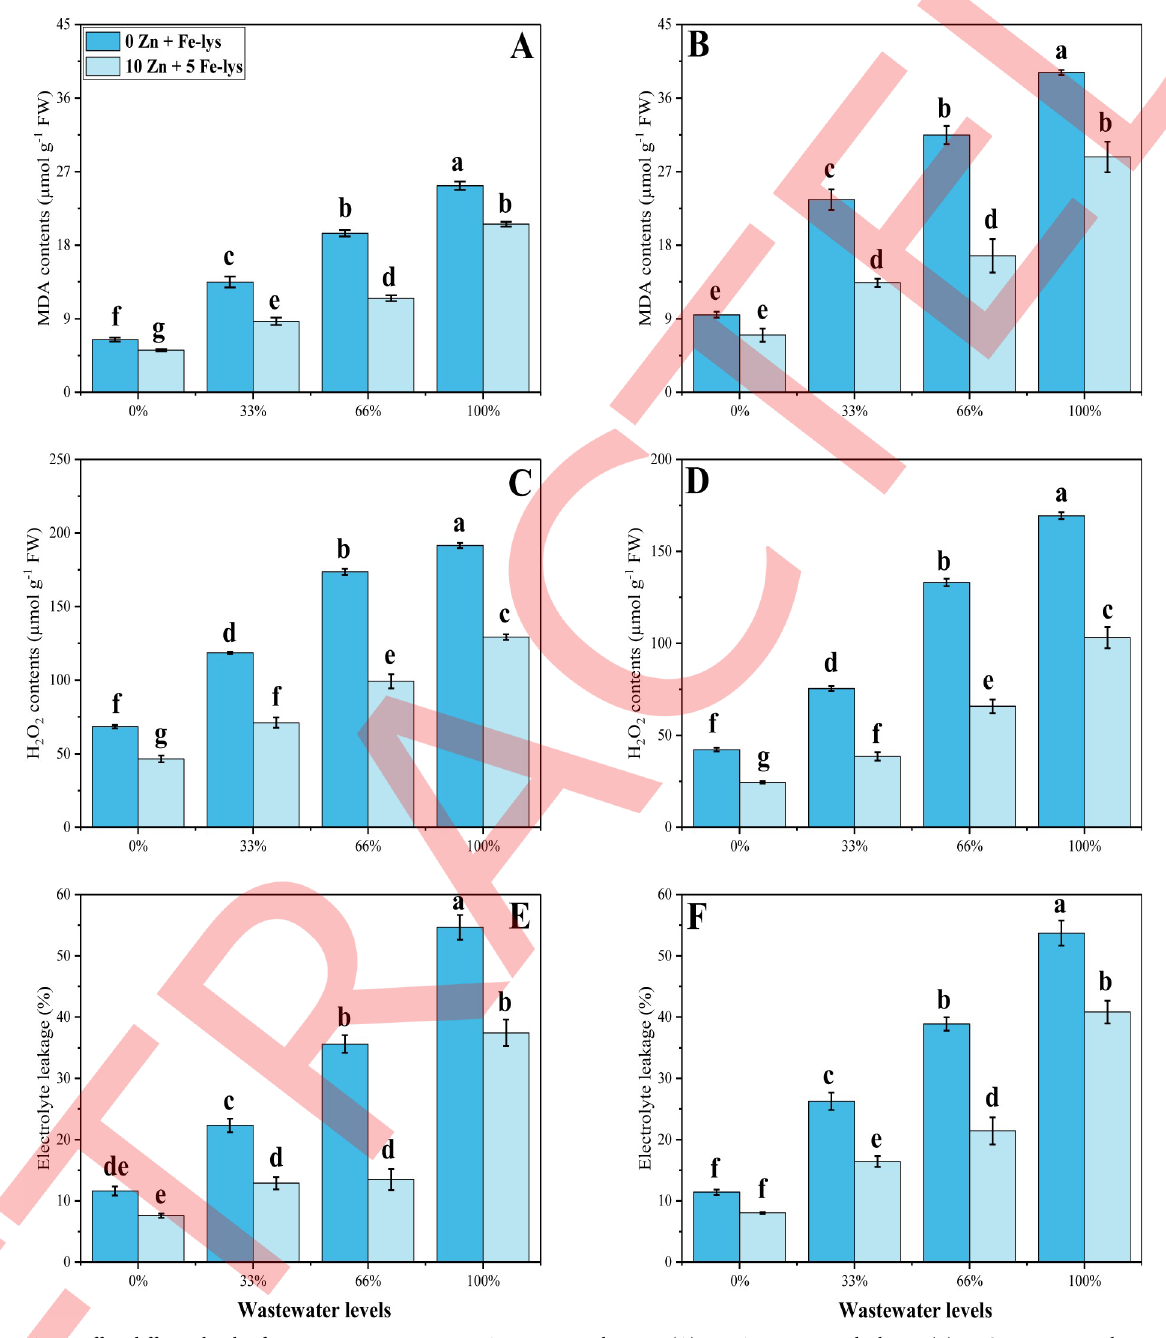
Fig 3. Effect different levels of tannery wastewater on MDA contents in the roots (A), MDA contents in the leaves (B), H 2 O 2 contents in the roots (C), H 2 O 2 contents in the leaves (D), EL percentage in the roots (E) and EL percentage in the leaves (F) under the application of Zn and Fe-lys on B . napus . Values are demonstrated as means of three replicates along with standard deviation (SD; n = 3). One-way ANOVA was performed and means differences were tested by HSD ( P < 0.05). Different lowercase letters on the error bars indicate significant difference between the treatments. Different levels of tannery wastewater used are as follow: 0 (without irrigation with wastewater), 33 (33% irrigation with wastewater), 66 (66% irrigation with wastewater) and 100 (100% irrigation with